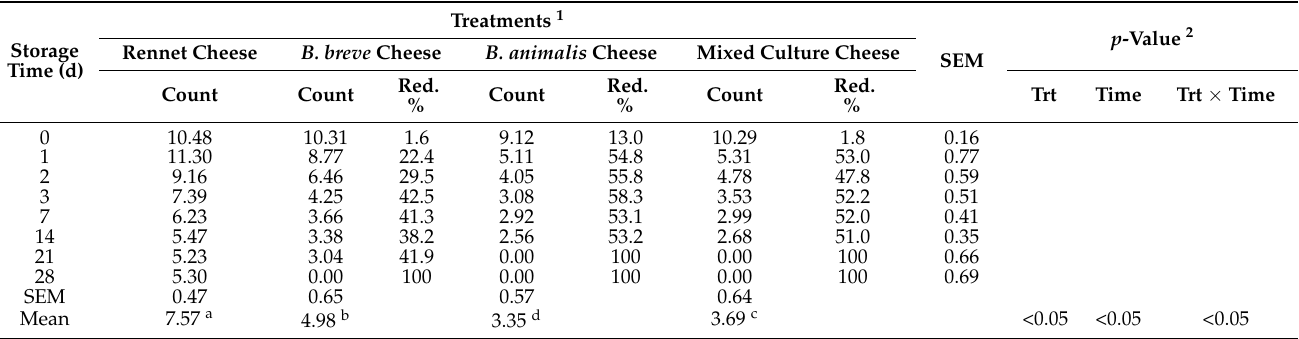
Table 3. Count (log cfu g − 1 ) and percentage reduction of L. monocytogenes inoculated in manufactured soft cheese with Bifidobacterium spp. stored at 4 ± 2 ◦ C.